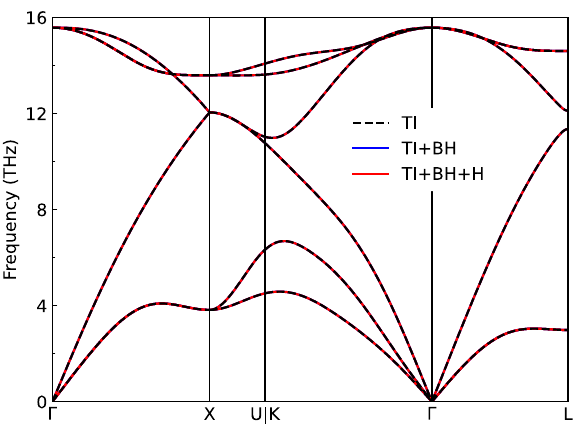
Fig. 2 In fl uence of invariance conditions on the phonon disper- sion of the infrared-active bulk CaP 3 . TI denotes the correction of translational invariance on the IFCs, while BH and H represent the corrections by Born-Huang rotational invariance and Huang condi- tions,